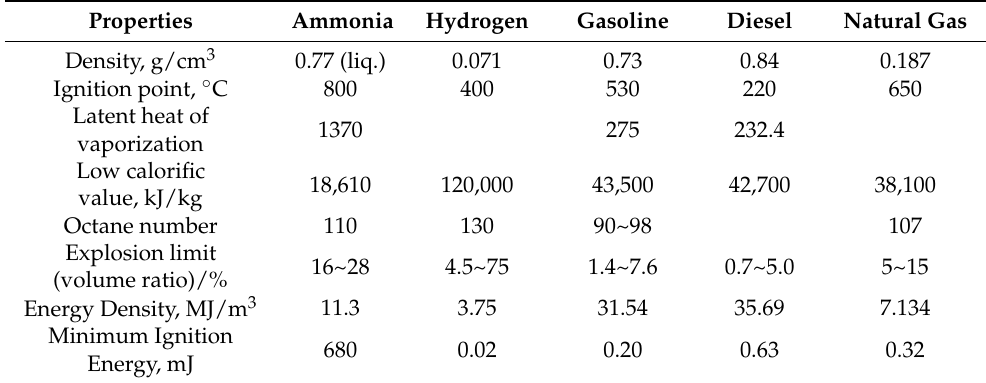
Table 1. Physicochemical properties of different